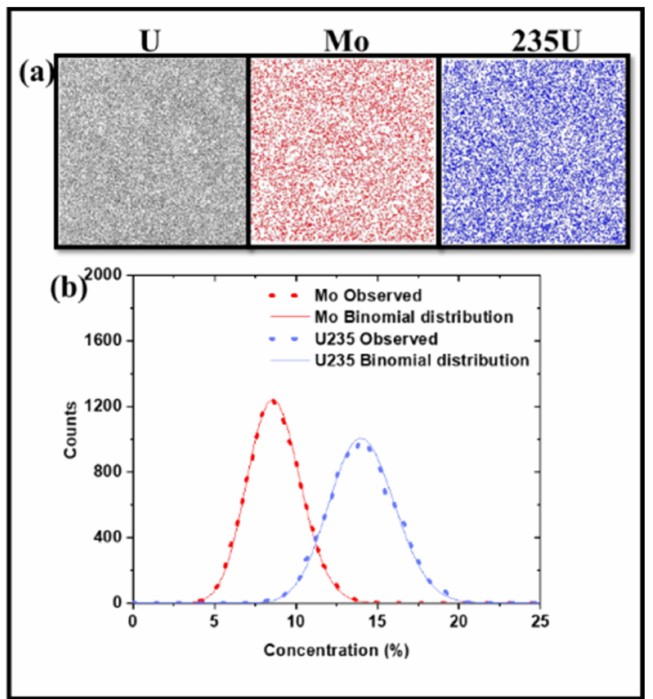
Figure 2. ( a ) 50 × 50 × 5 nm cuboid showing distribution of U, Mo, and 235U isotope. ( b ) Observed and binomial distribution of Mo and 235U isotope in analyzed volume obtained using APT from as-received U-7 wt.% Mo.